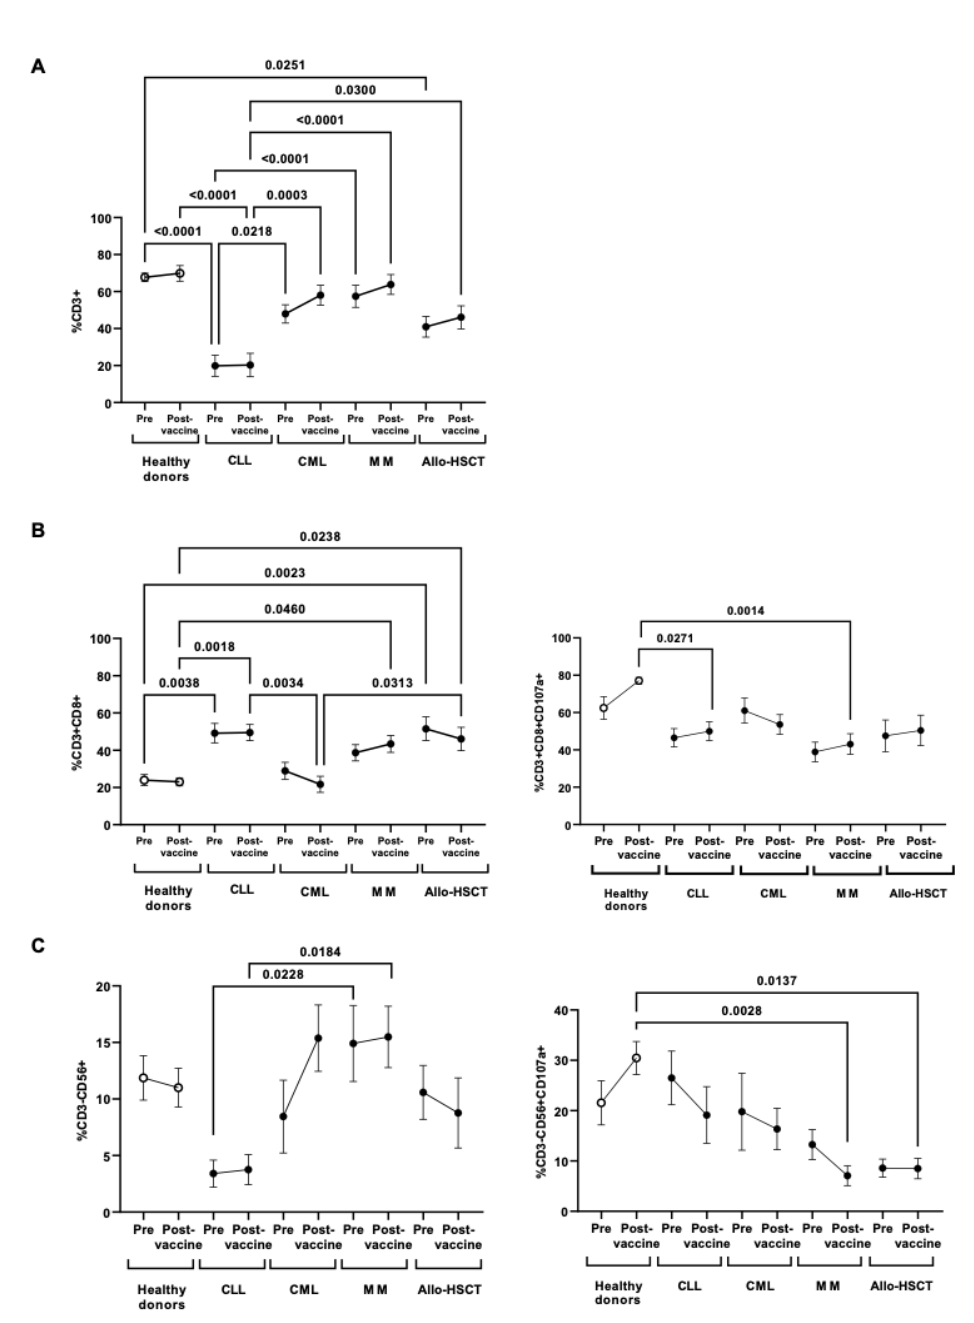
Figure 5. Characterization of the cellular cytotoxic populations in PBMCs from individuals with OHD before and after receiving one-dose vaccination. ( A ) Total CD3 + T cells in peripheral blood mononuclear cells (PBMCs) from individuals with oncohematological diseases (OHD) was evalu- ated by flow cytometry, in comparison with healthy donors. ( B ) CD8 + cell count ( left graph ) and expression of CD107a in these cells ( right graph ) was determined in PBMCs from individuals with OHD, in comparison with healthy donors. ( C ) NK cell count ( left graph ) and expression of CD107a in these cells ( right graph ) was determined in PBMCs from individuals with OHD, in comparison with healthy donors. Each dot in the graphs corresponds to mean ± SEM. Statistical significance between groups was calculated using one-way ANOVA test.